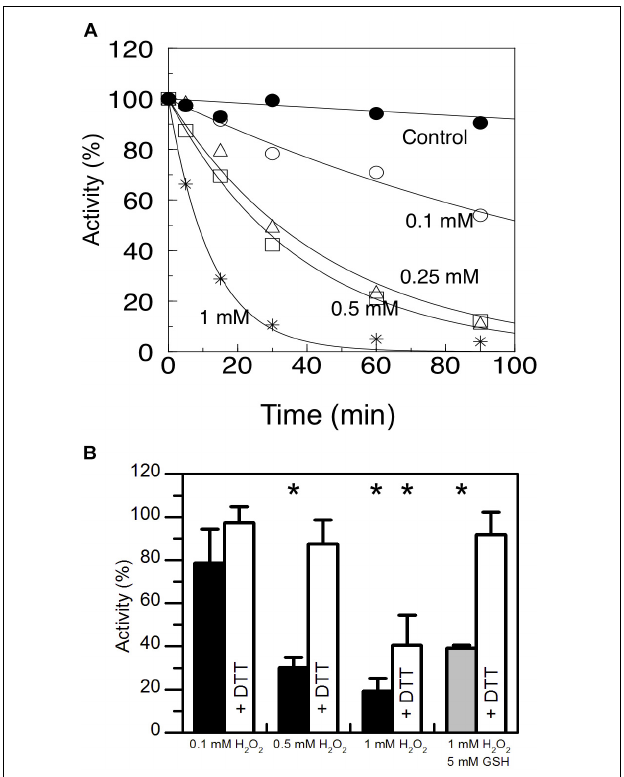
FIGURE 1 | Sensitivity of At AMY3 to oxidative treatments. (A) Time- dependent inactivation of At AMY3 by 0.1 mM H 2 O 2 (open circles), 0.25 mM H 2 O 2 (open triangles), 0.5 mM H 2 O 2 (open squares), 1 mM H 2 O 2 (asterisks). Tricine-NaOH buffer was used as a control (closed circles). At the indicated time points, α -amylase activity was measured on aliquots of the incubation mixtures. Activities are expressed as percentages of the control activity measured at t = 0. Values are mean ± SD ( n = 3; SD < 10% are omitted for clarity). (B) Inactivation of At AMY3 after 1 h incubation with 0.1 mM, 0.5 mM, 1 mM H 2 O 2 (black bars), and 1 mM H 2 O 2 plus 5 mM GSH (gray bar). The recovery of At AMY3 activity (white bars) was tested by incubating treated samples for additional 30 min with 80 mM DTT. Activities are expressed as percentages of control (untreated) sample. Data are reported as mean ±